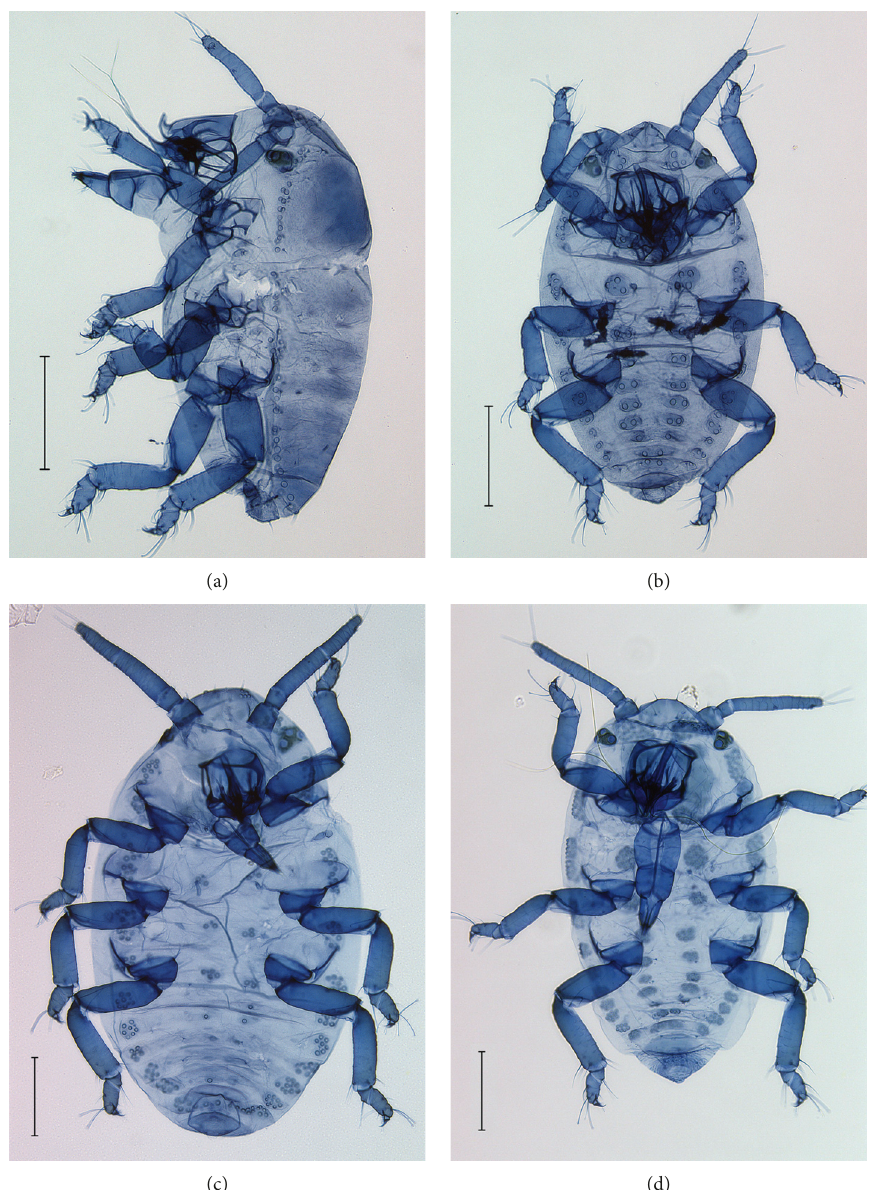
Figure 9: Nymphs of Neothoracaphis yanonis : (a) first-instar nymph to be aptera (collected from Quercus serrata on 8 October 2014); (b) first-instar nymph to be alate sexupara (collected from Q. serrata on 8 October 2014); (c) first-instar male produced by the alate sexupara (collected from Q. serrata on 13 November 2013 and fixed on 18 November 2013); (d) first-instar female (collected from Distylium racemosum on 23 November 2013). All aphids were collected in Tama, Tokyo, Japan. Scale bars: 100 μ